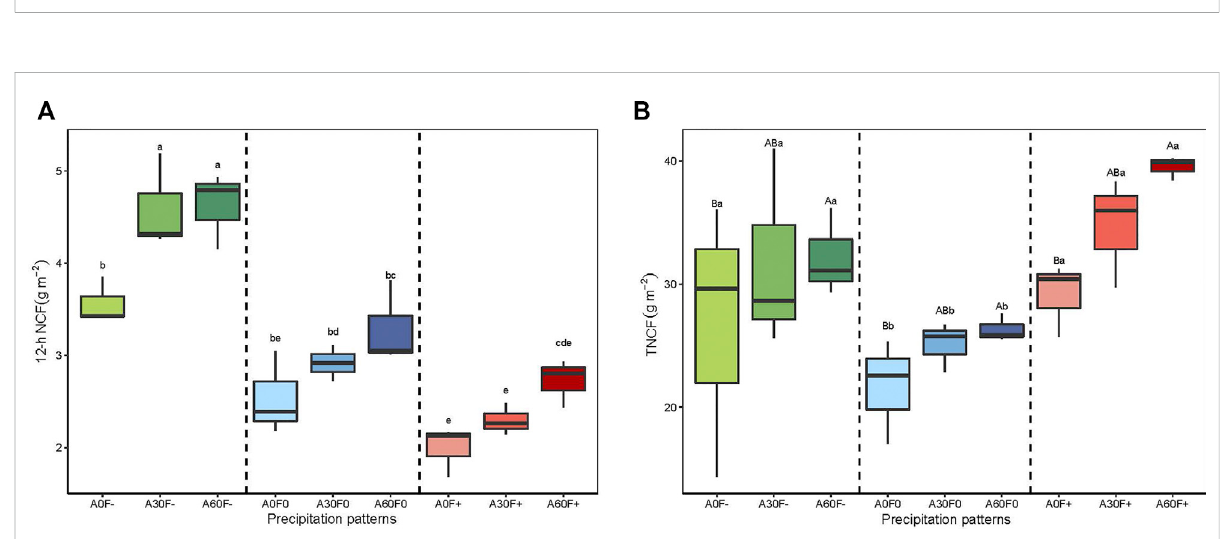
FIGURE 2 (a) 12-h NCF of soil covered with cyanobacterial crust; (b) TNCF of soil covered with cyanobacterial crust; statistically signi fi cant differences in precipitation amount are denoted with capital letters whereas statistically signi fi cant differences of precipitation frequency are denoted with lowercase letters. 12-h NCF: 12-h cumulative net carbon fl ux; TNCF: total net carbon fl